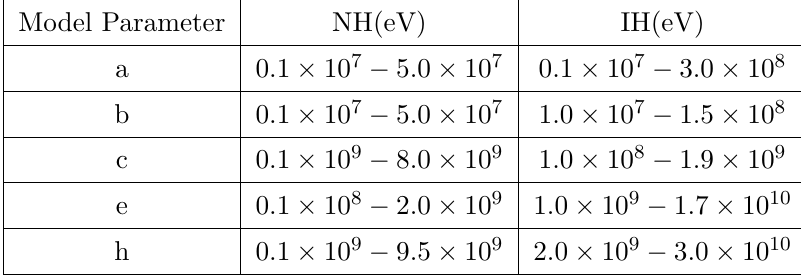
Table 5 . Allowed range of the model parameters satisfying DM-active